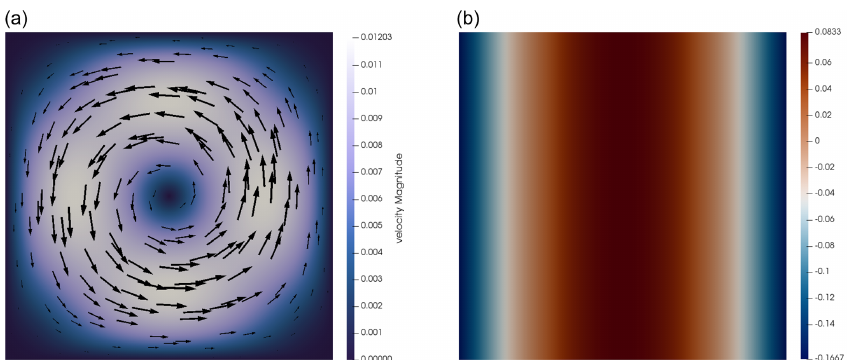
Figure 1. Donea and Huerta benchmark. Velocity (a) and pressure (b) fields obtained on a 32 × 32 mesh with Q 2 × Q 1 elements.